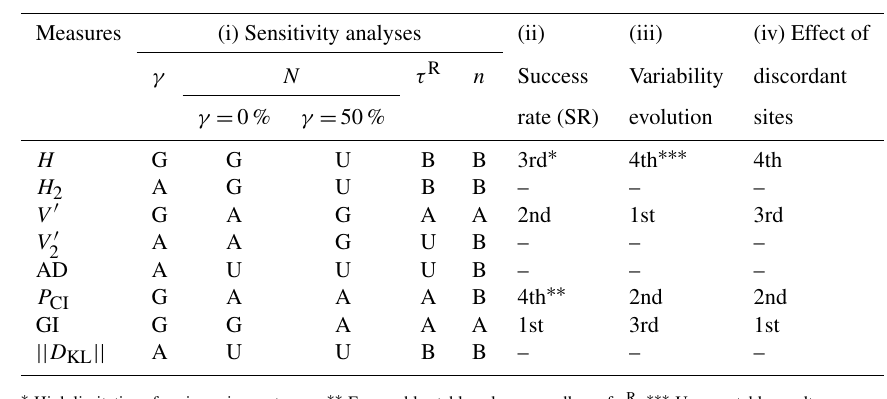
Table 1. Summary of the results of the studied measures for the four-step assessment procedure. The behaviour of a given measure for each sensitivity analysis in step (i) is graded as follows: good (G), acceptable (A), bad (B), or unacceptable (U). Measures entailing an “unacceptable (U)” behaviour are not assessed by the rest of steps; yet a complete assessment of H is performed for comparison purposes. For steps (ii), (iii), and (iv), considered measures are ranked from the best results (1st) to the worst results (4th).